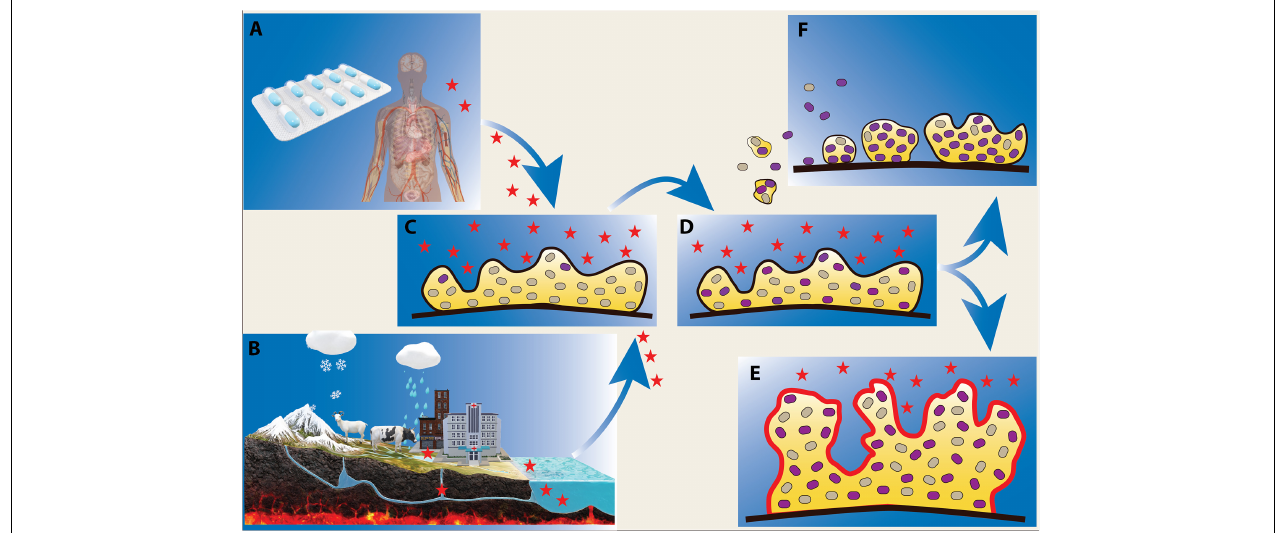
FIGURE 1 | Effect of low levels of antibiotics on microbial biofilms. Biofilm bacteria are often exposed to low levels of antibiotics during infection treatment and antibiotic therapy (A) , and in natural water reservoirs where there is a flux of antibiotics from sources such as agriculture, aquaculture, hospital and domestic waste (B) . Exposure of biofilms to antibiotics (indicated as red stars) (C) can lead to the emergence of antibiotic resistant phenotypes/genotypes (D) (shown as purple cells) and facilitate formation of more robust biofilms (E) . Upon antibiotic exposure, resistant biofilm bacteria can further disseminate and serve as inocula for potentially more resistant biofilm communities (F)